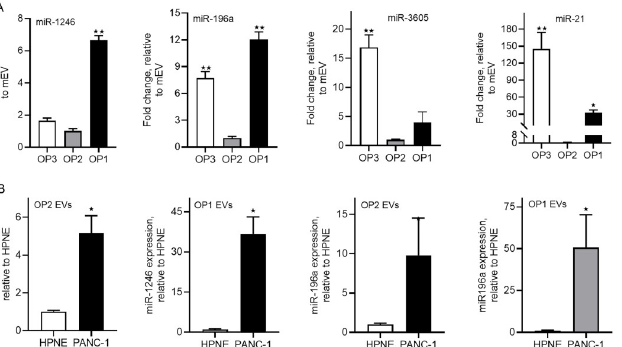
Fig 3. Expression of miR-1246 and miR-196a in the OP1, OP2 and OP3 groups of EVs derived from PANC-1 and hTERT-HPNE cells. A . qRT-PCR (80ng total RNA used for each cDNA synthesis) analysis of miR-1246, miR-196a, miR-21, and miR-3605 expression in the OP1, OP2 and OP3 group of EVs derived from PANC-1 cells. B . A comparison of miR-1246 and miR-196a expression between PANC-1- and hTERT-HPNE-derived OP1 and OP2 group of EVs. � . P < 0.05, �� , p < 0.01, unpaired Student t-test (n =